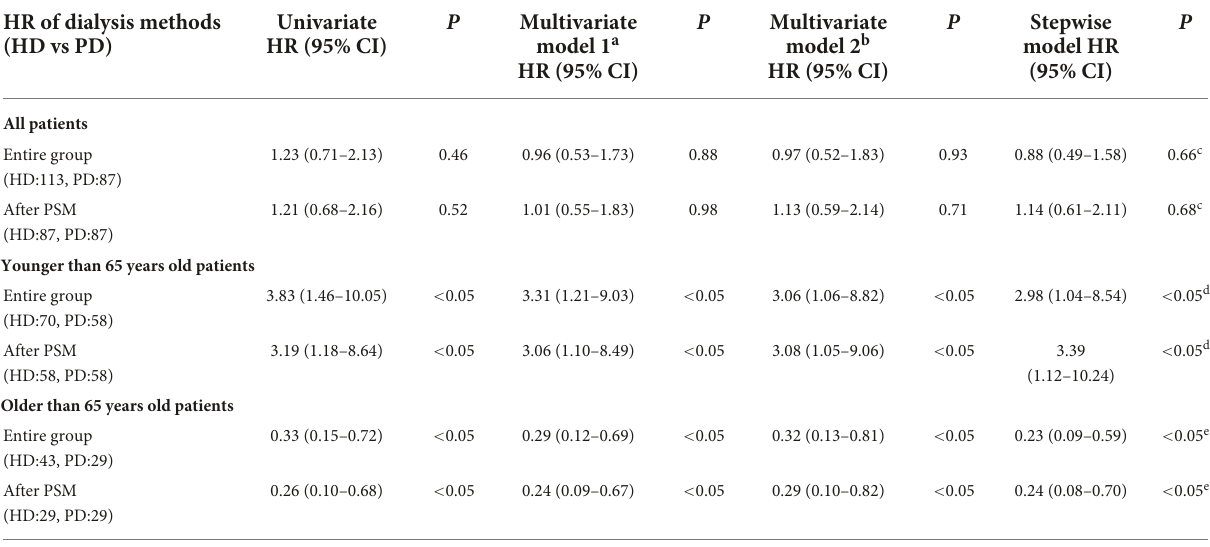
TABLE 6 Crude and adjusted hazard ratios for all-cause mortality with HFpEF (LVEF > 55%) according to dialysis method. HR of dialysis methods (HD vs PD)